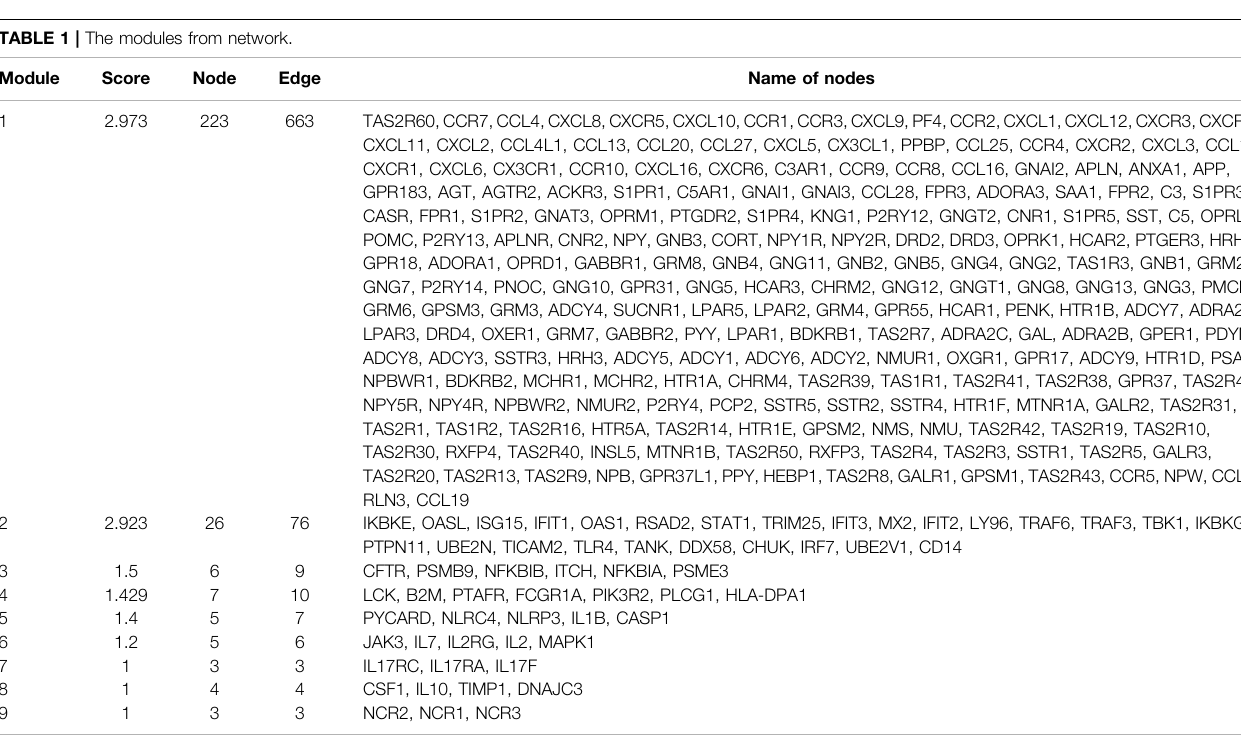
TABLE 1 | The modules from